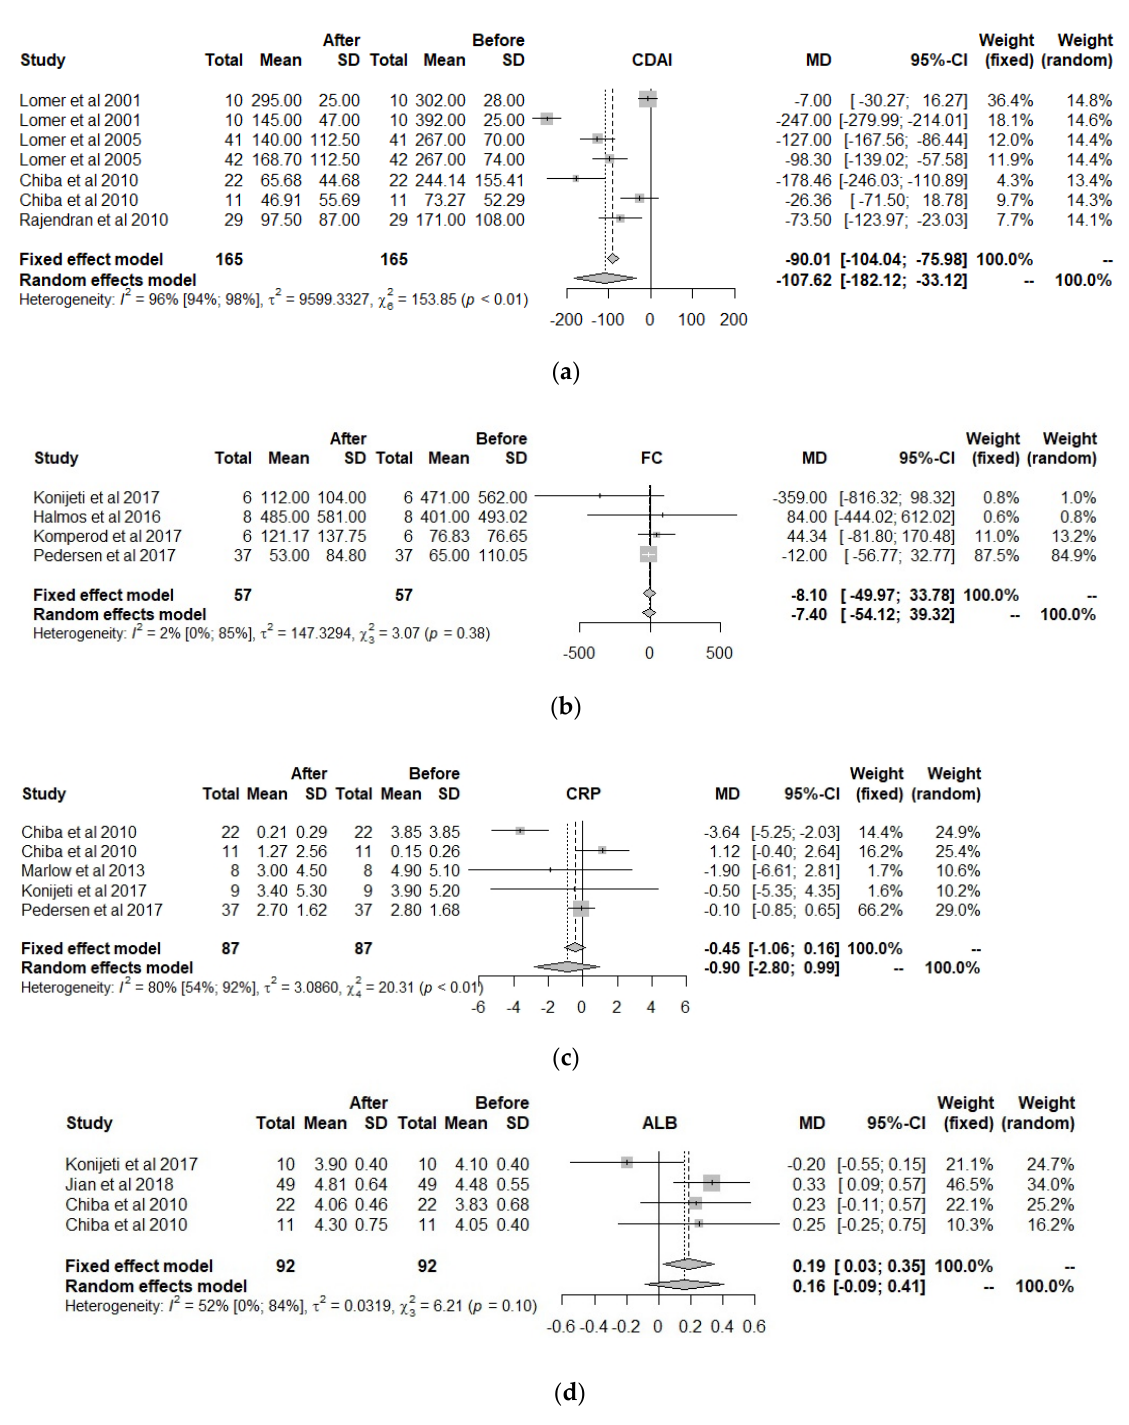
Figure 3. Forest plot for ( a ) Crohn’s Disease Activity Index (CDAI), ( b ) Fecal Calprotectin (FC), ( c ) C-Reactive Protein (CRP), and ( d ) Albumin (ALB).